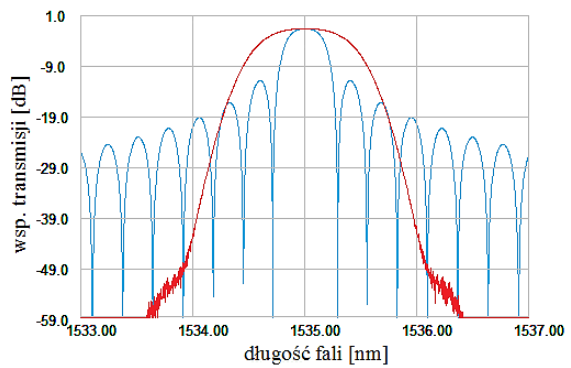
Fig. 13. Comparison of Bragg fiber gratings spectral characteristics without apodization – blue line and apodized cosine function for wsp. А = 5- red